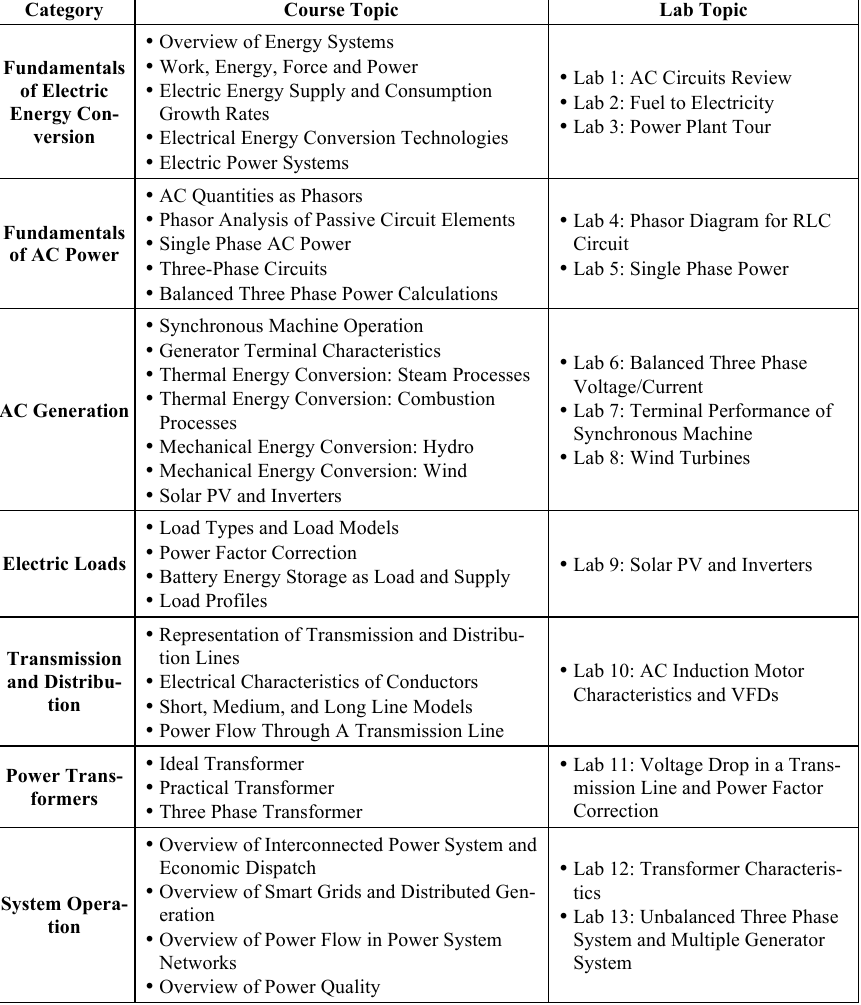
Table 4. Topic Schedule for Modern Energy Systems